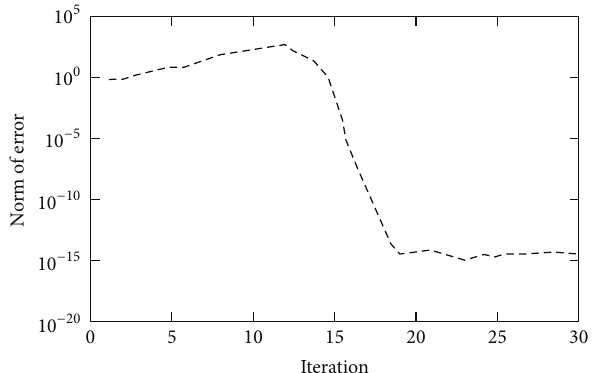
Figure 2: Convergence of the proposed ILC method at the initial value 𝑢 0 = 0.7 with 𝜖 = 0.4